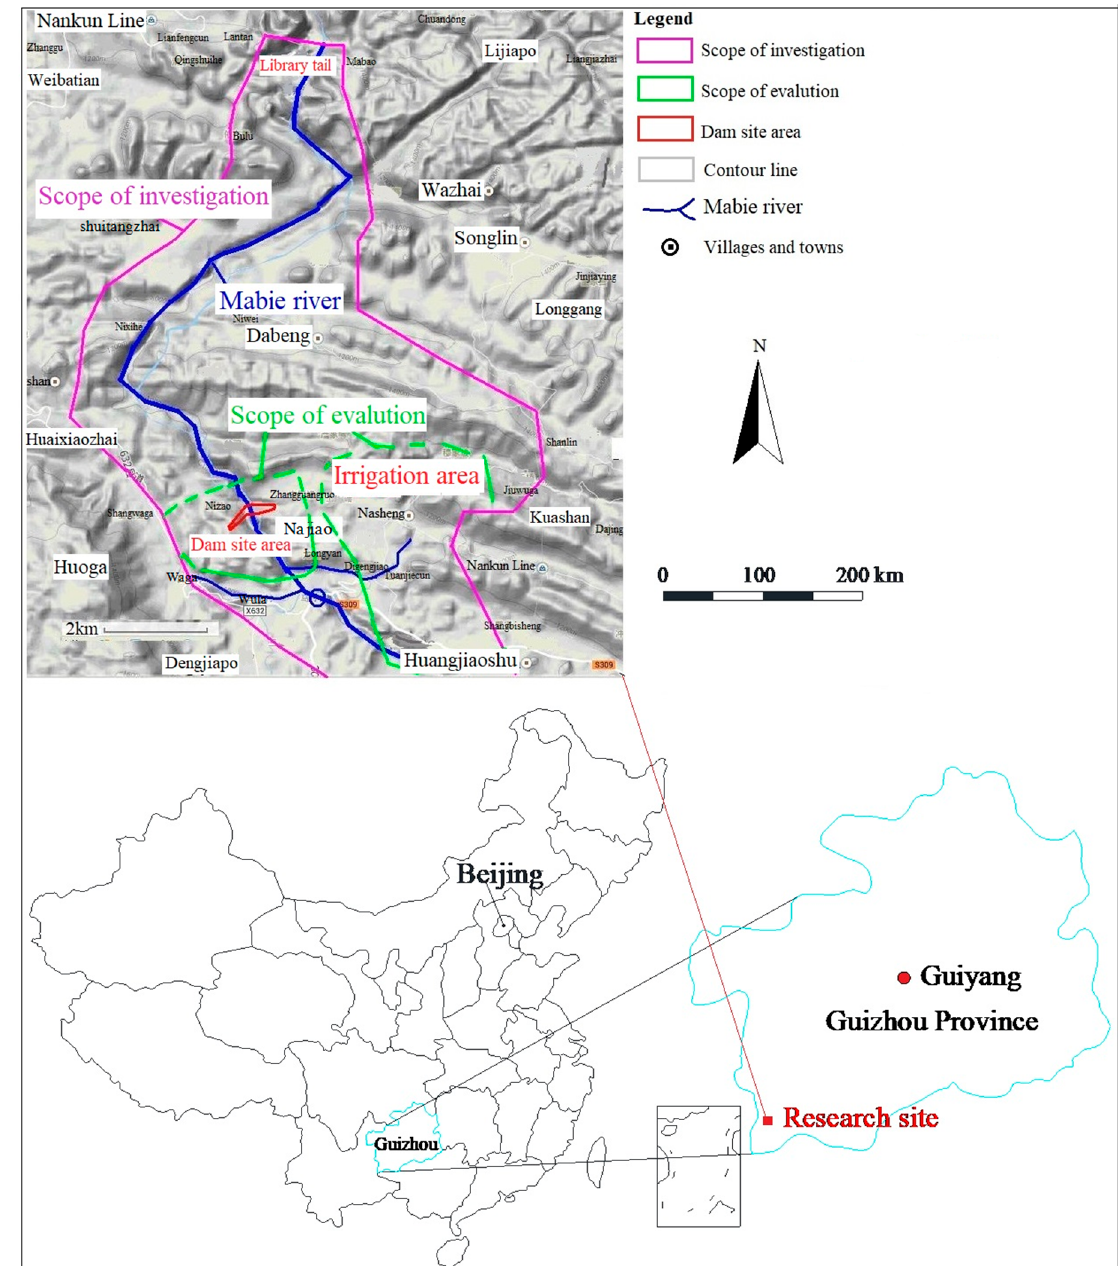
Figure 1. Location of study area.